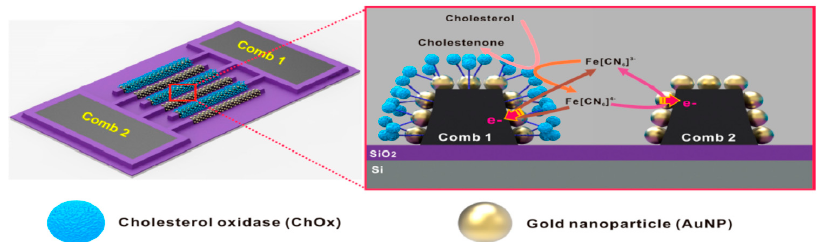
Figure 4. Schematic diagram of the sensing principle based on the redox cycling of [Fe(CN) 6 ] 3 − /[Fe(CN) 6 ] 4 − between enzyme and electrode surfaces at nano-sized gold nanoparticle (Au-NPs)/carbon interdigitated electrodes (IDEs), selectively functionalized with cholesterol oxidase (ChOx); Working electrodes (comb 1: enzyme-functionalized Au-NPs/carbon comb, comb 2: non-functionalized Au-NPs/carbon comb. Image reproduced from [44] with permission.